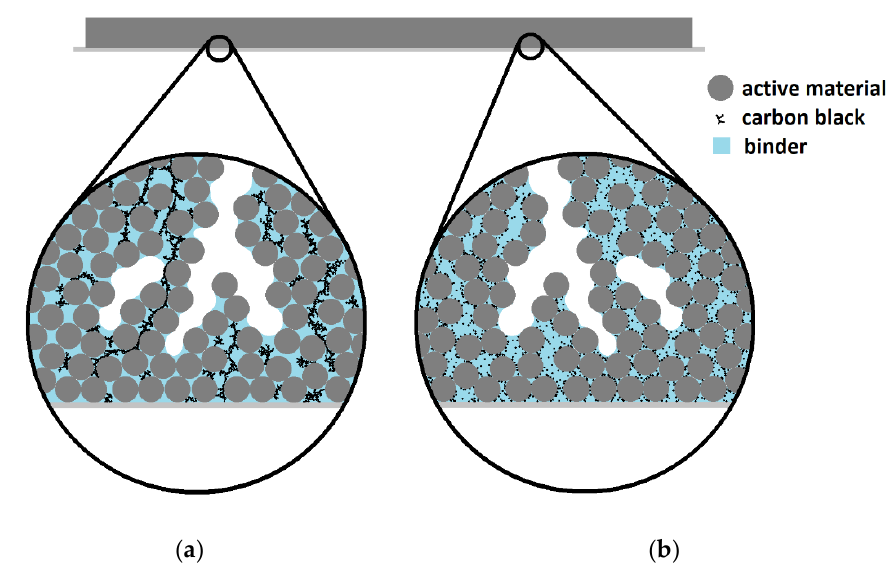
Figure 1. Conceptual cross-sectional diagram of a hard carbon anode film illustrating the inefficiencies in: ( a ) short-range and ( b ) long-range conductive additive networks.